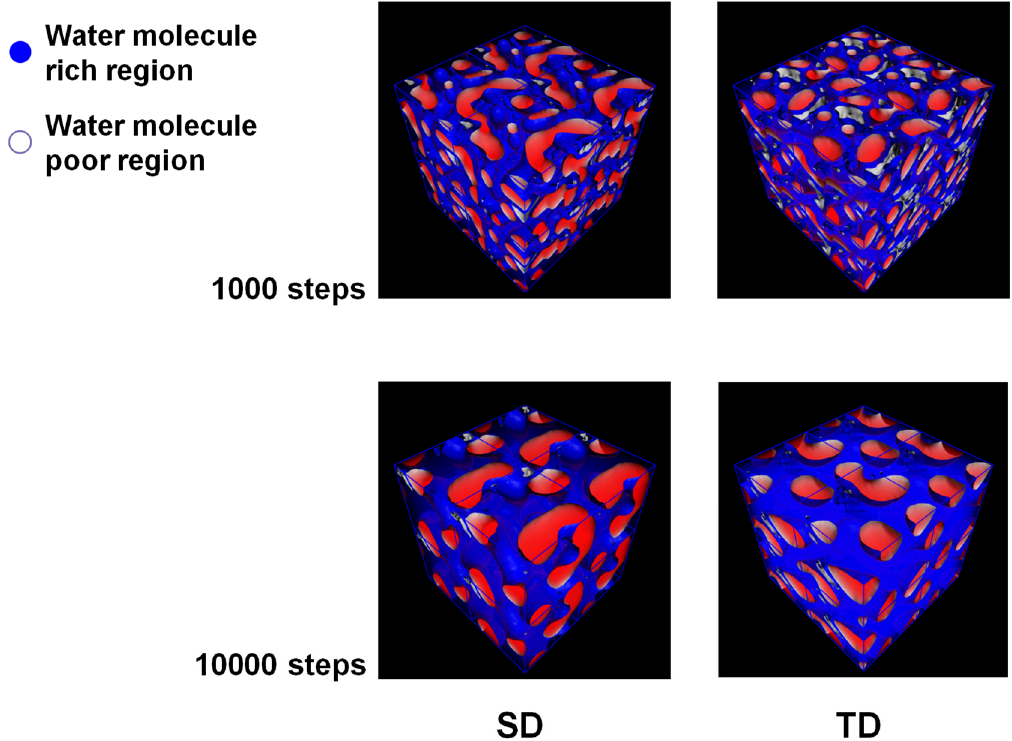
Figure 3. Three-dimensional images of the mesoscale results at 298 K after 1000 and 10,000 steps.